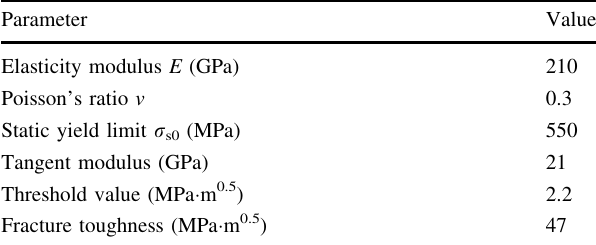
Table 1 Material parameters of U71Mn